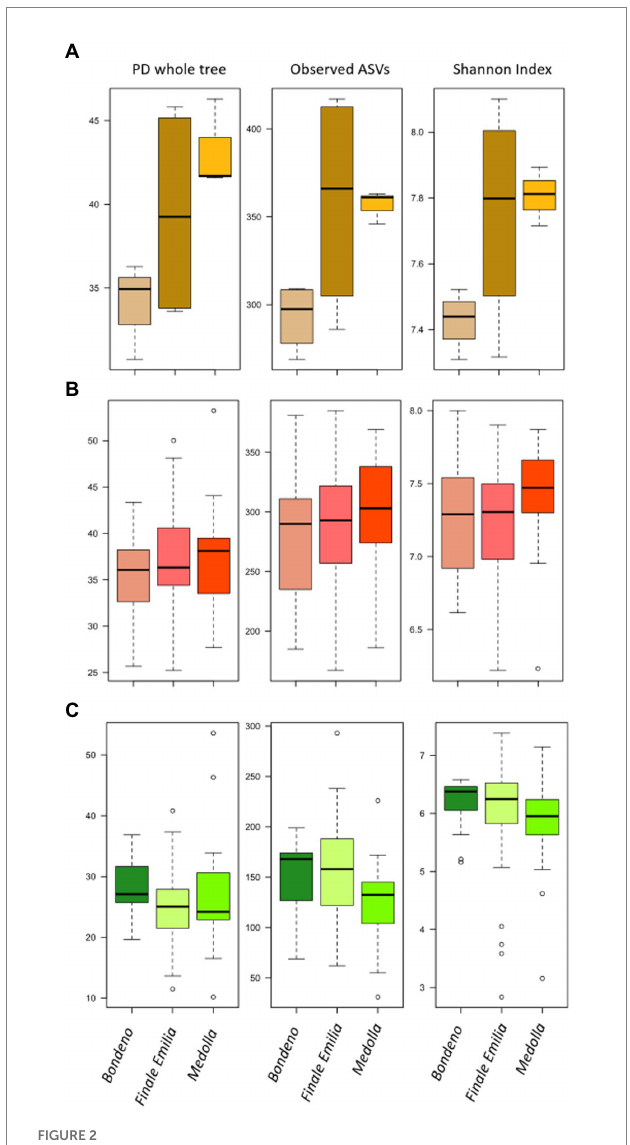
FIGURE 2 Alpha diversity of bulk soil and of Vitis vinifera rhizosphere and root microbiomes in the three studied farms. Box-plots showing the distributions of the Faith’s Phylogenetic Diversity (PD whole tree), Observed ASVs and Shannon Index calculated for the bulk soil (A) , the rhizosphere (B) , and the root (C) in the three sampled vineyards (located in Bondeno, Finale Emilia, and Medolla). The only significant differences were observed for the bulk soil samples ( p ≤ 0.05, Kruskal– Wallis